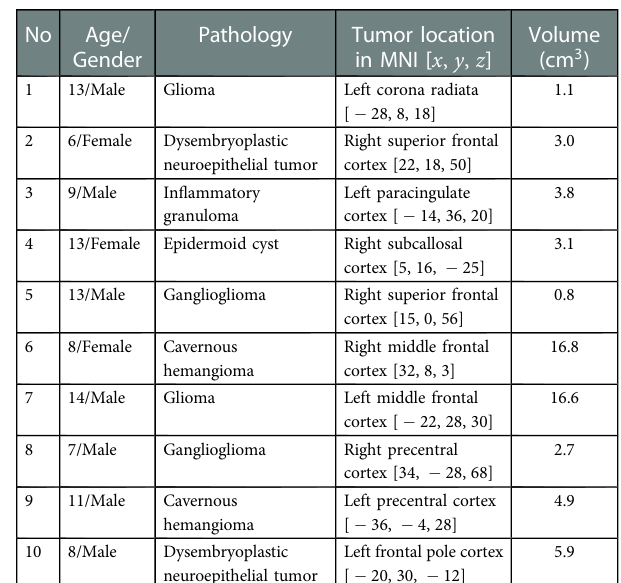
TABLE 1 Patients ’ clinical characteristics.